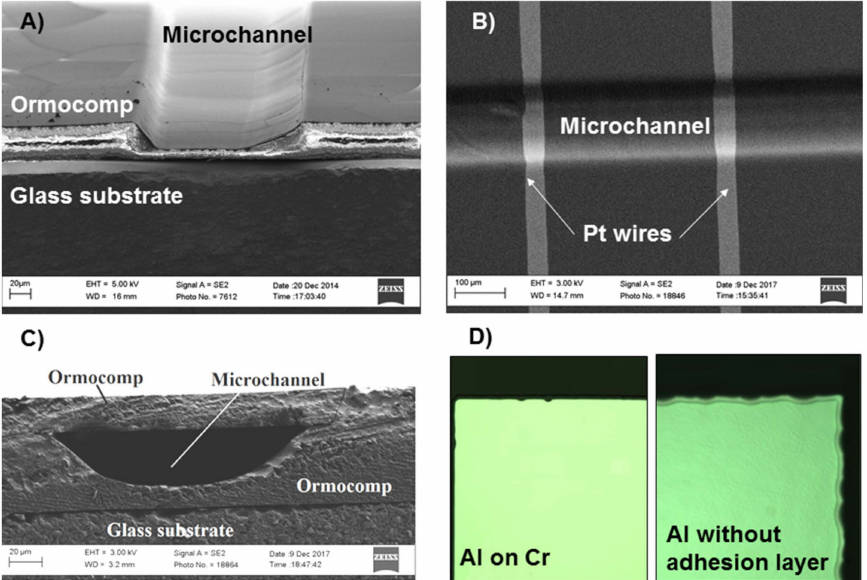
Figure 3. A scanning electron micrographs of ( A ) the cross-section of Ormocomp microchannel fabricated exploiting controlled overexposure ( ≥ 19 mJ / cm 2 ) and featuring tilted side walls, ( B ) Pt wires (50 µ m wide, 220 nm thick) crossing an Ormocomp channel, and ( C ) the cross-section of a bonded Ormocomp microchannel. ( D ) Comparison of the etch profile of Al thin-film metal in AZ351B developer with and without adhesion layer (17 nm